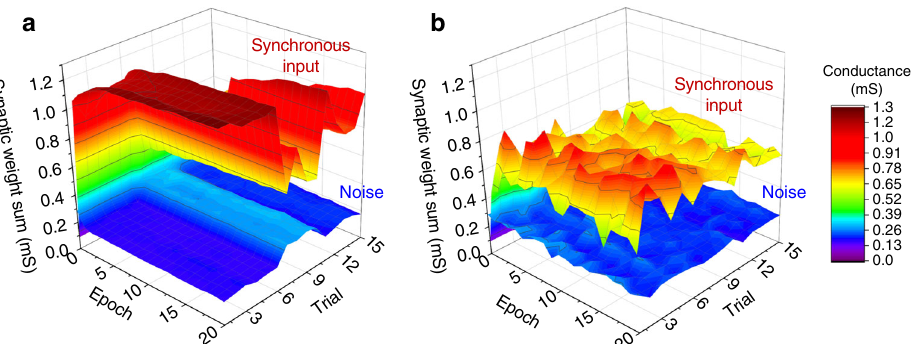
Fig. 6 Trial statistics. Coincidence detection experiment repeated 15 times when connecting LIF neuron to a column #2 with p spike = 1, with no jitter or offset added; and b column #19 with p spike = 1, ( t jitter ) max = 25 ms, and ( Δ offset ) max = 200 ms. The noise spikes were generated randomly and were unique for each frame in all